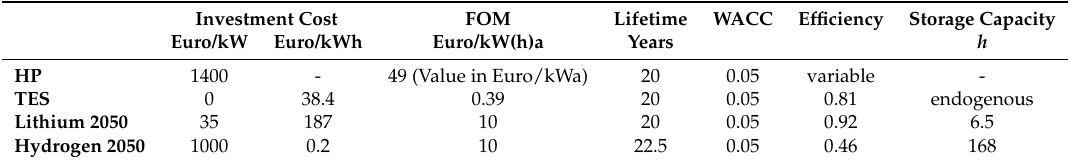
Table 2. Data for the decentral heating system based on [11], data for the electricity storage based on [23,36,37]. Storage efficiency is shown as round trip